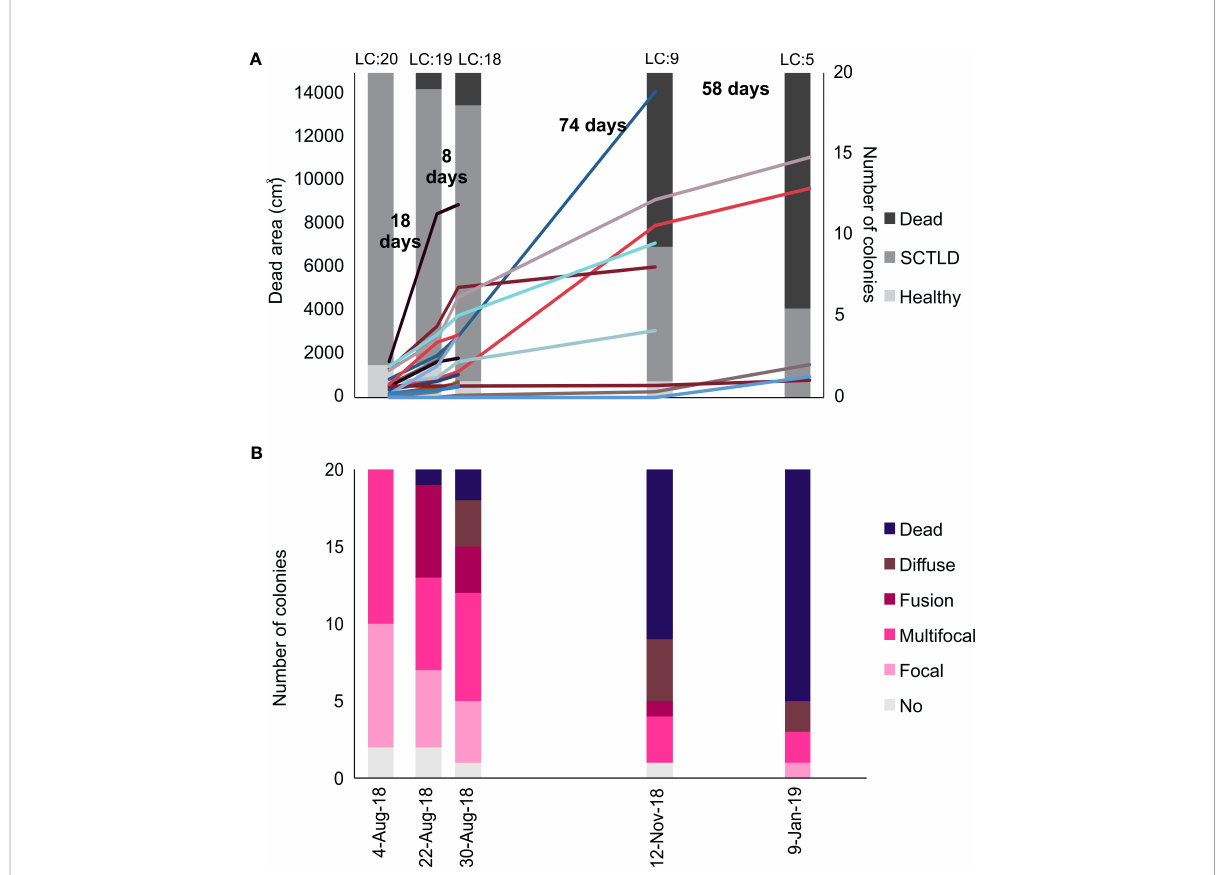
FIGURE 2 Disease progression in the 20 colonies of P. strigosa tagged in Limones reefs. (A) Number of colonies affected by the Stony Coral Tissue Loss Disease, dead and healthy, and the lesion area per colony. The number between columns represents the number of days between each survey and each of the colored lines represents one of the 20 colonies. (B) Type of lesion present in the colonies. The LC: above de columns represent the number of live colonies for each